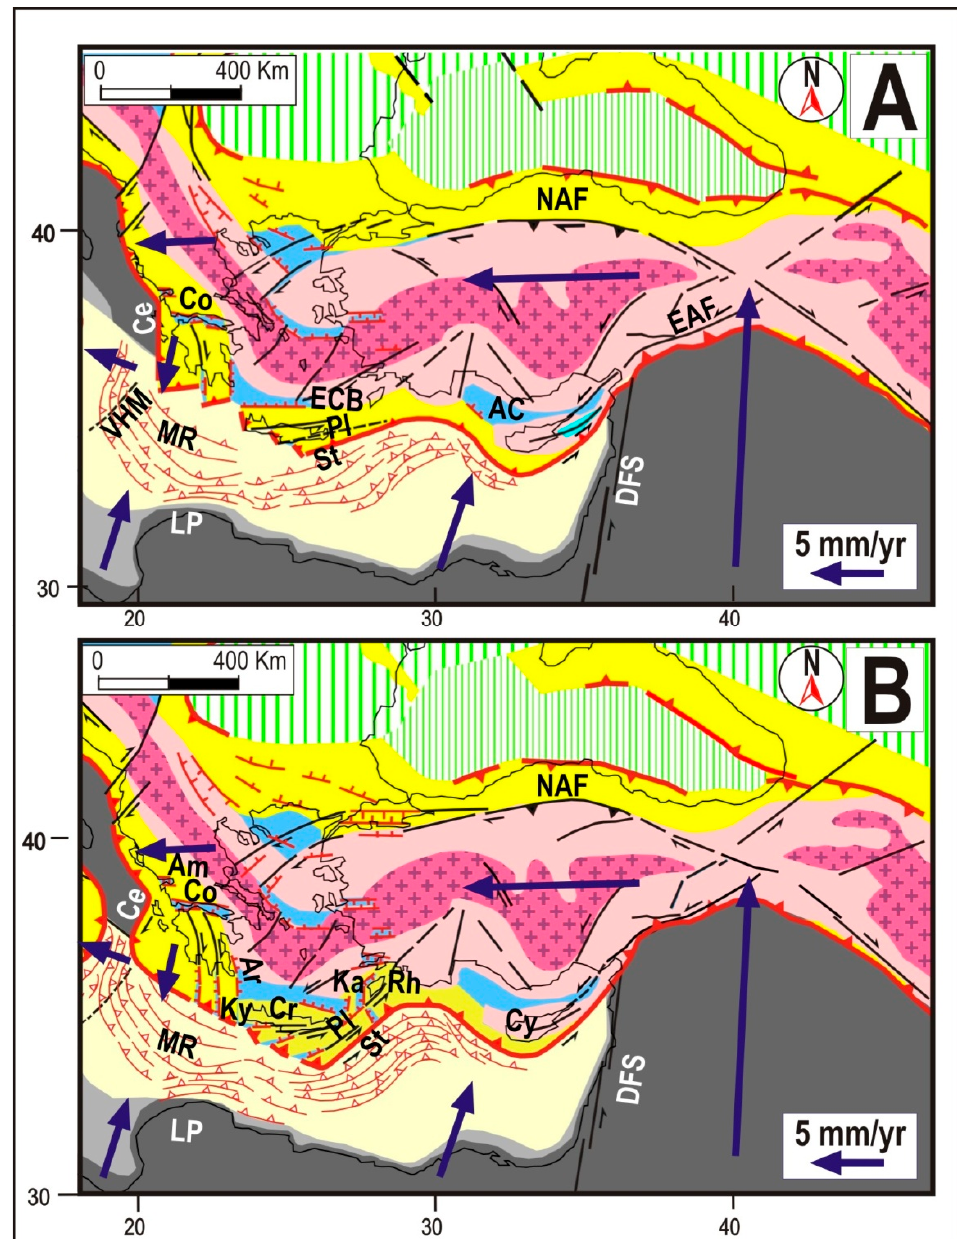
Figure 9. ( A ) Late Pliocene paleogeographic configuration. AC—Antalya–Cilicia basin; Ce—Ceph-